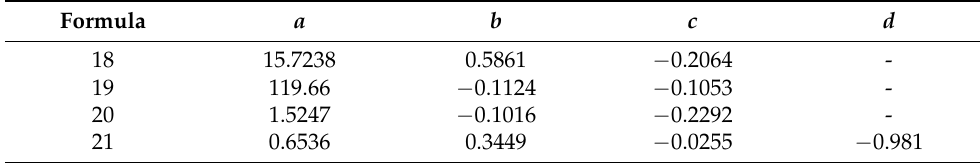
Table 14. PCI decay equation regression parameter values.